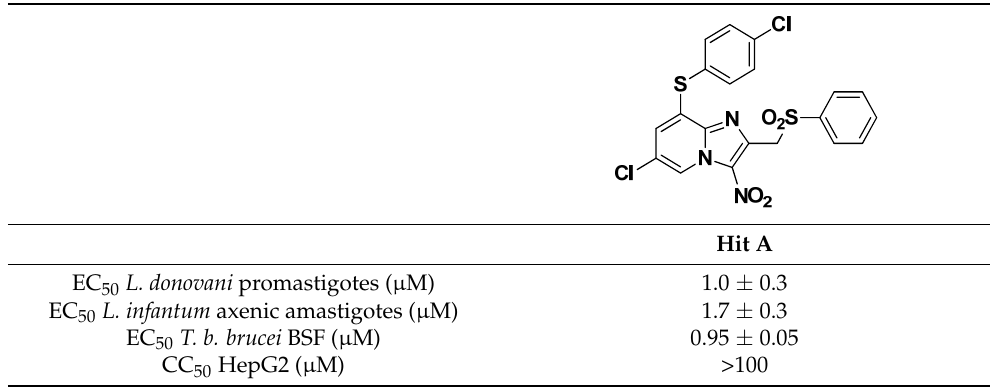
Table 1. Structure and biological profile of previously identified Hit A .